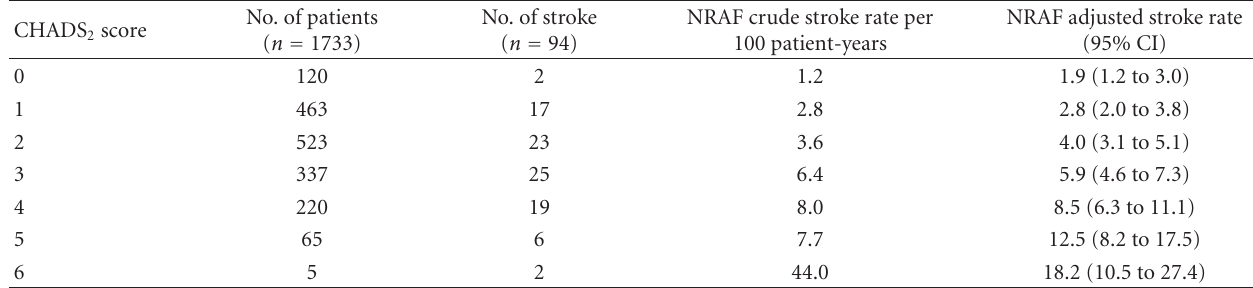
Table 4: CHADS 2 score quantification of stroke risk for patients with atrial fibrillation. NRAF: National Registry of Atrial Fibrillation. From